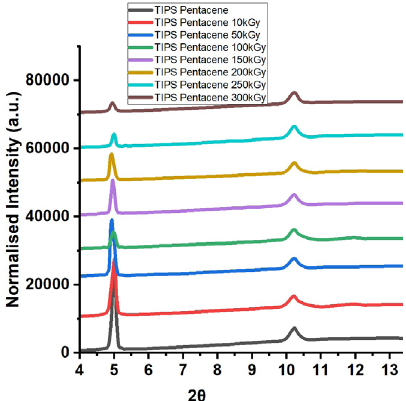
Figure 2. XRD spectra of TIPS Pentacene before and after irradiation with different total ionizing doses.